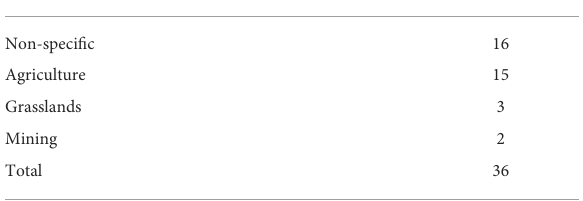
TABLE 2 Literature survey results for publications that examined enhanced weathering as a method for carbon dioxide removal, categorized by the context in which this practice was examined (see methods in section Literature survey of enhanced weathering study methodology and